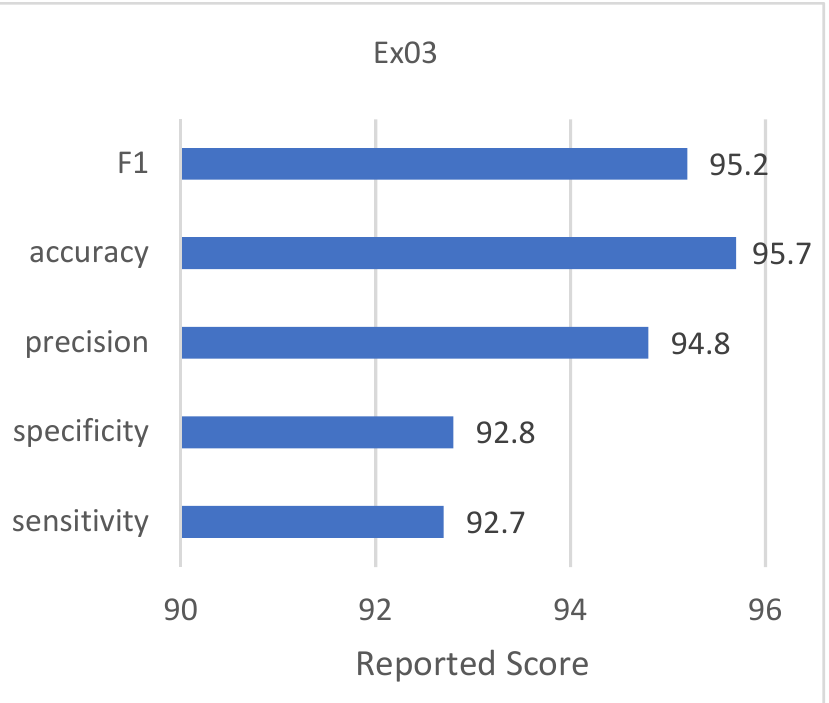
Figure 12. Reported accuracy scores of applying Model_I on Dataset_I (EX03). Classifying Dataset_I into (a) RA cases; (b) controls; (c) synthetic samples.